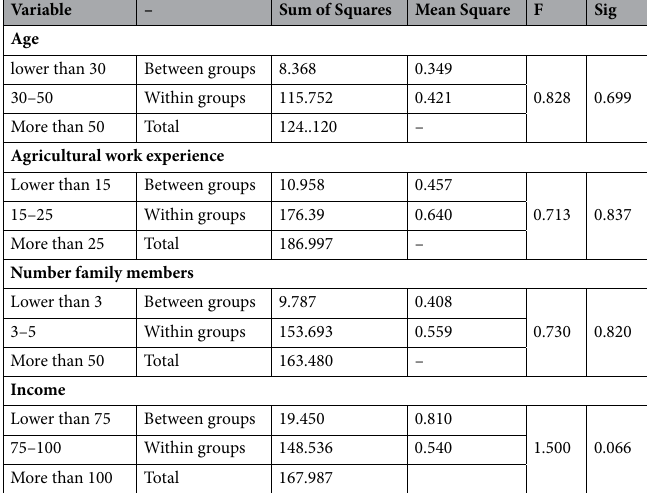
Table 3. The compare of farmers’ SCBs based on multilevel variables.